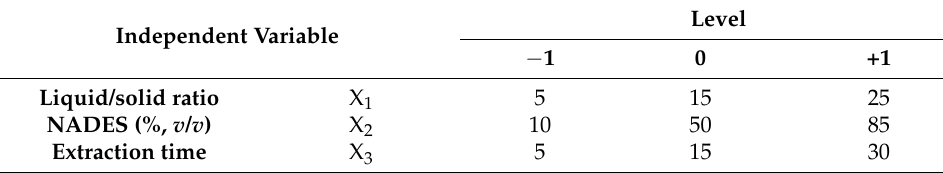
Table 2. Coded levels of independent variables.